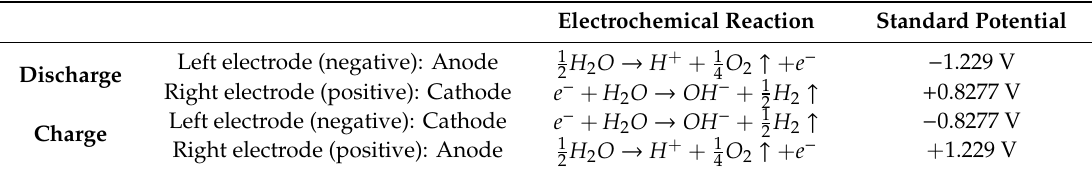
Table 1. Electrode reactions during charge and discharge.